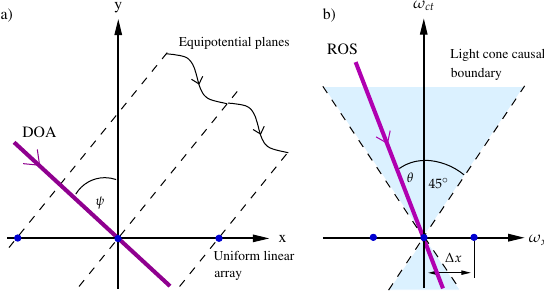
Figure 1. Plane wave received at a uniform linear array of antennas with spacing ∆ x in ( a ) 2-D space ( x , y ) domain and ( b ) 2-D space-time ( x , ct ) domain.